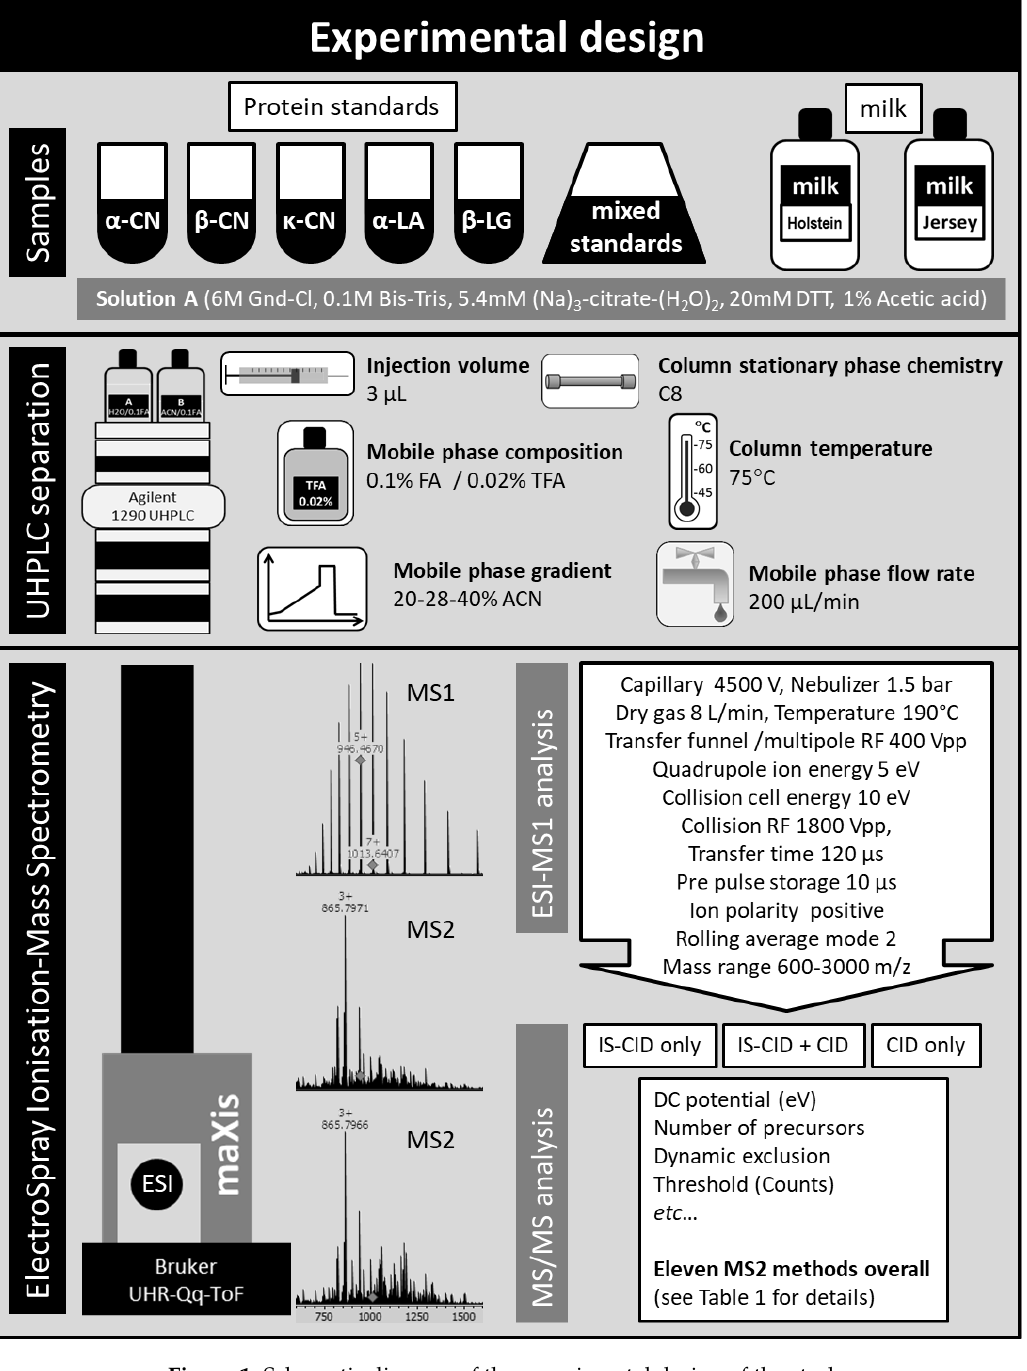
Figure 1. Schematic diagram of the experimental design of the study.